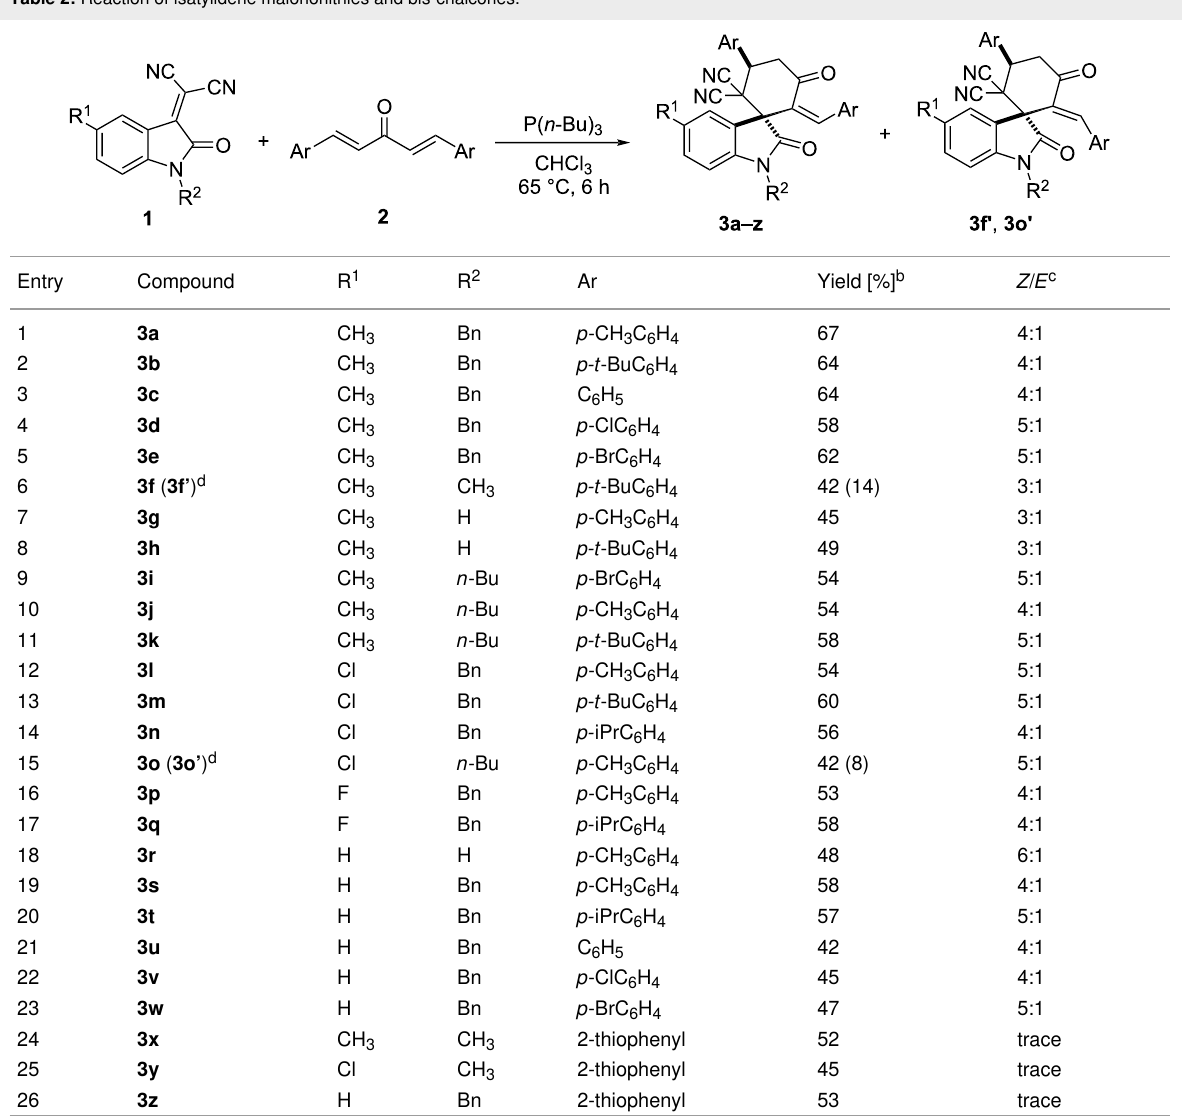
Table 2: Reaction of isatylidene malononitriles and bis-chalcones.